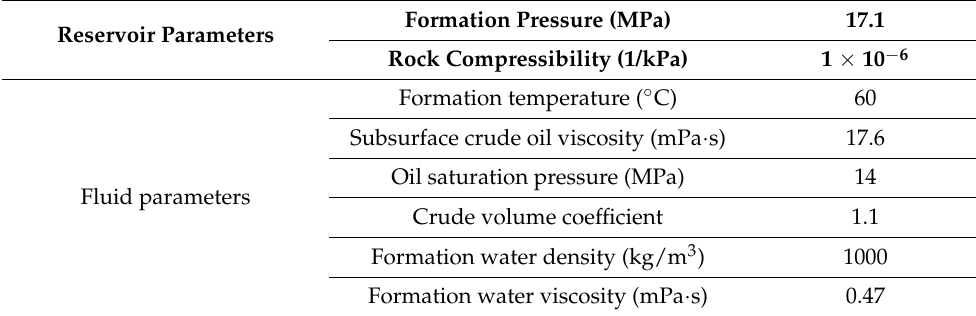
Table 6. Basic parameters of the